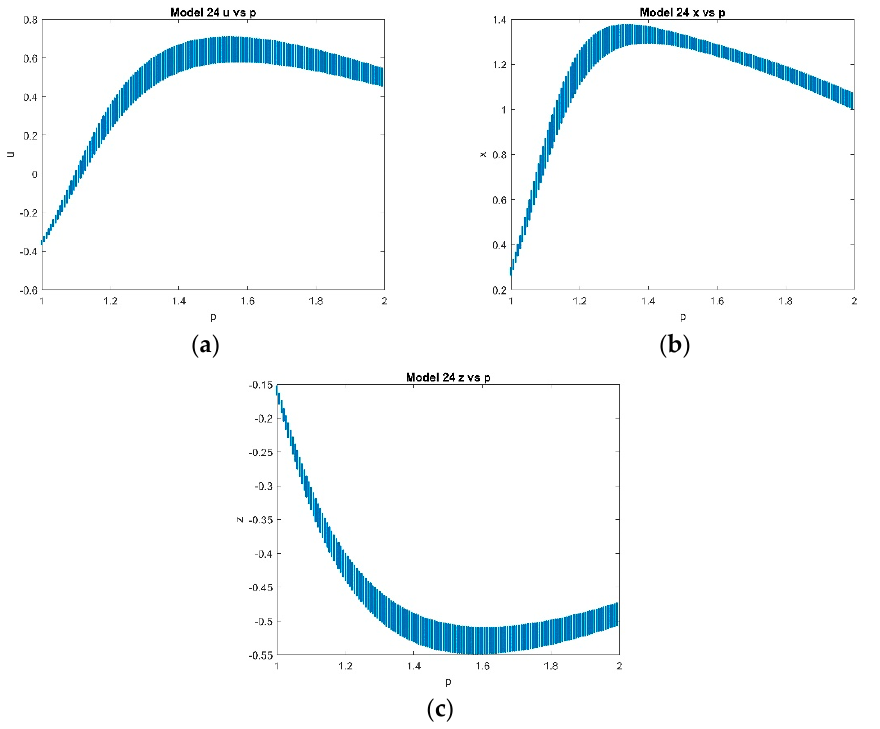
Figure 14. ESDDFD2 model (24); ( a ) 𝑢 vs 𝑝, ( b ) 𝑥 vs 𝑝, ( c ) 𝑧 vs 𝑝 , at 𝑘 = 2, 𝛼 (cid:2873) = 0.3,𝑝 ∈ [1,2(cid:4671) .